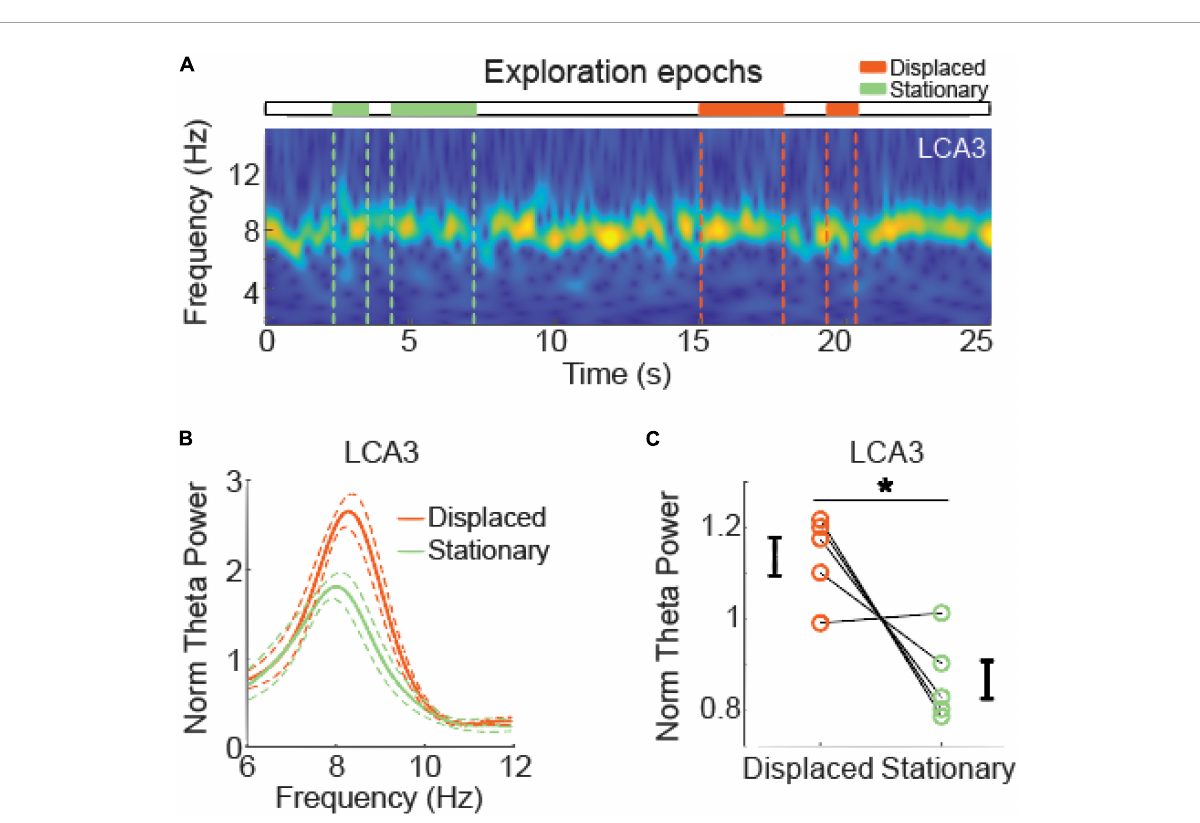
FIGURE5 Theta oscillations in CA3 during exploration of displaced and stationary objects in the high displacements (HD) tests. (A) Representative spectrogram of local field potentials (LFP) signals from the left CA3 area during a high displacement test. Horizontal bars and vertical dashed lines depict time intervals of exploration of displaced and stationary objects (orange and green, respectively). (B) Normalized average power spectra at the theta (6–12 Hz) band in the left CA3 during exploration of displaced and stationary objects in HD tests. Solid lines represent mean and dashed lines represent SEM. (C) Normalized mean theta power in the left CA3 during exploration of displaced and stationary objects. Circles represent mean theta power of individual rats and error bars represent SEM. Asterisks represent statistical significance in a paired t test, n = 5